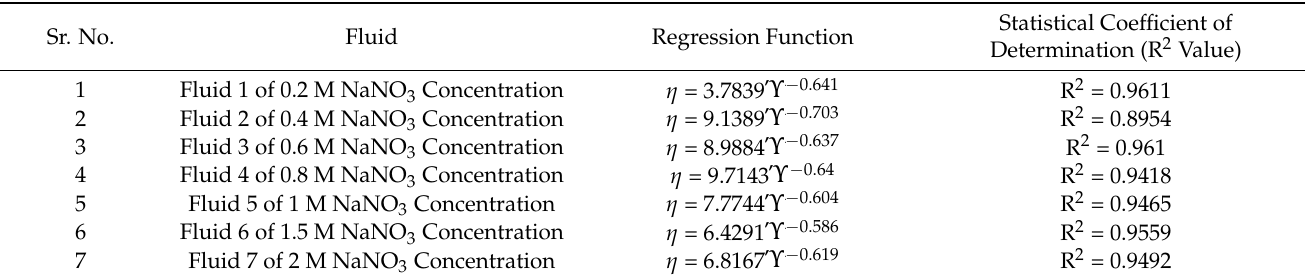
Table 1. Regression functions for viscosity change with a varying shear rate of different viscoelastic type1 fluids at Temperature 25 ◦ C.